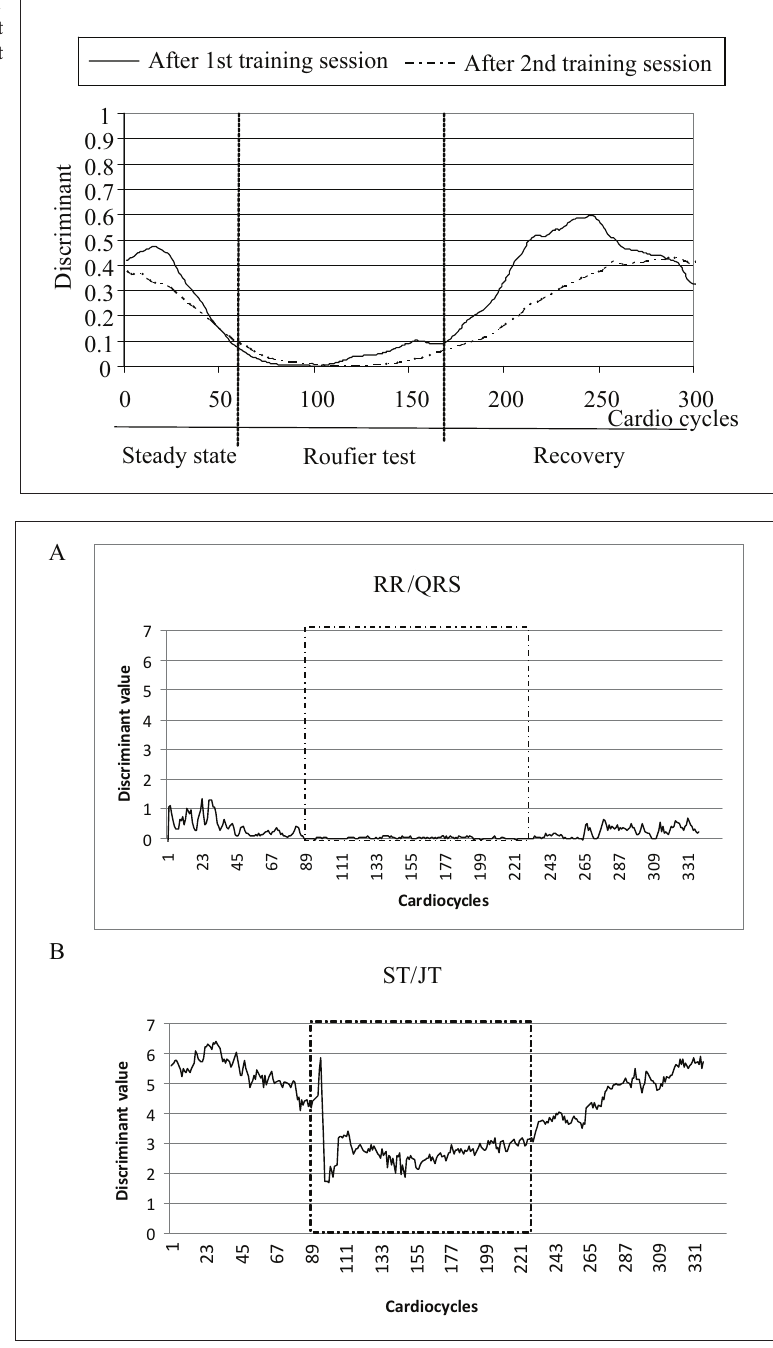
Note. Dotted-line square indicates physical load during the exercise test. Figure 2. Dynamics of RR interval and QRS complex interaction (systemic level – regulatory processes) (A) and concatenation of ST segment amplitude and JT interval duration (subsystemic level – cardiac metabolism processes) (B) during dosed exercise test (subject M. E.)